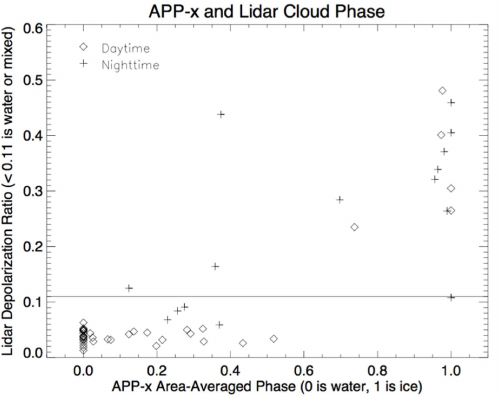
Figure 9. Cloud particle phase from the AVHRR and LiDAR depolarization ratio during the SHEBA year. Depolarization ratios less than 0.11 are primarily water or mixed-phase clouds. The AVHRR results use a value of zero for water and one for ice; intermediate values correspond to scenes with both phases